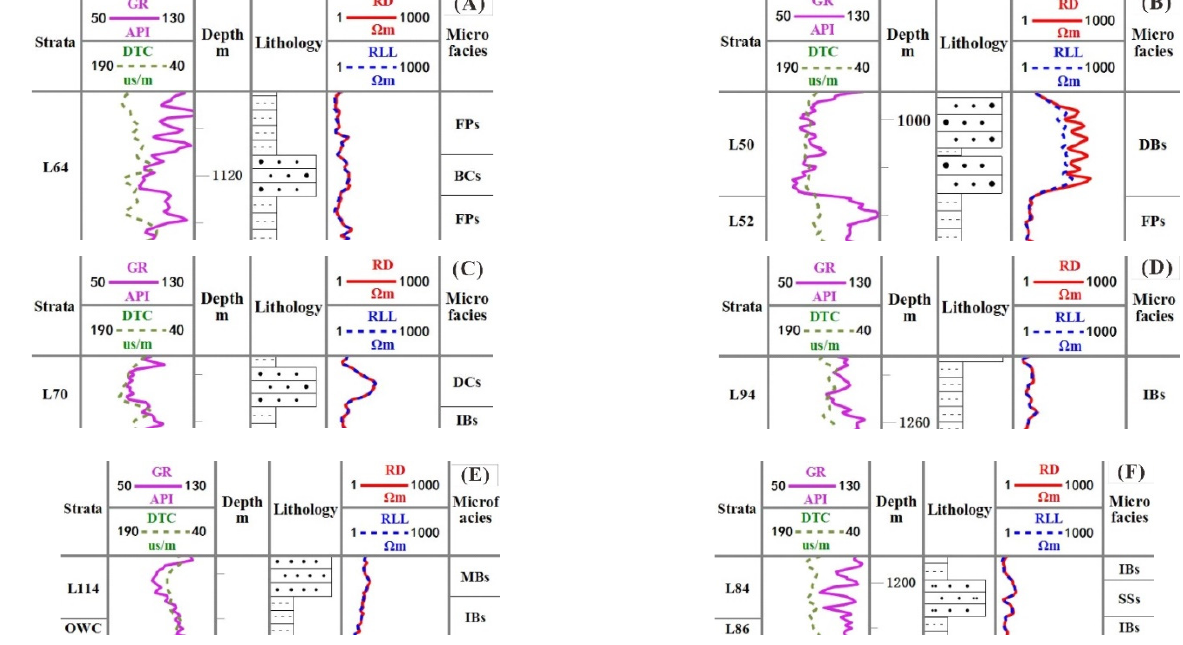
Figure 9. ( A − F ) Log response of typical sedimentary microfacies in wells PL19 − 3 − A, PL19 − 3 − B, and PL19 − 3 − D. DC = distributary channel; BC = braided channel; FP = flood plain; DB = distributary bar; IB = interdistributary bay; MB = mouth bar; SS = sheet sand. Table 1. Sedimentary characteristics and logging response.